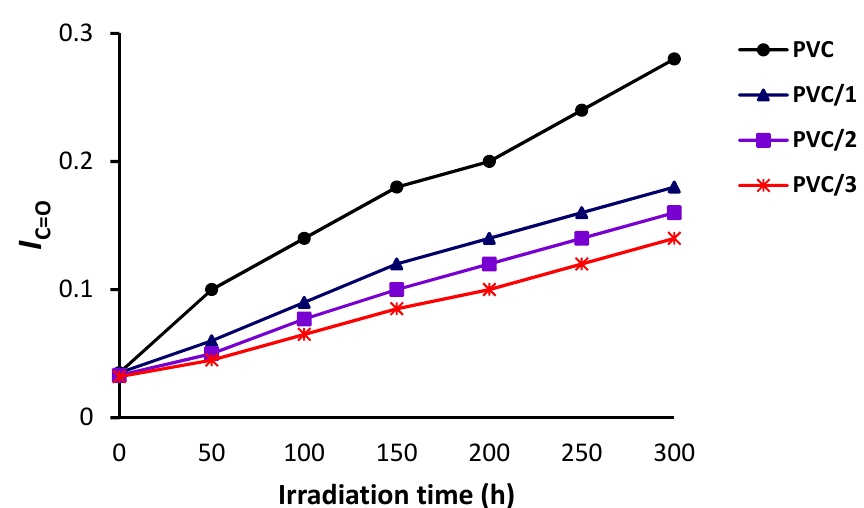
Molecules 2019 , 24 , 2396